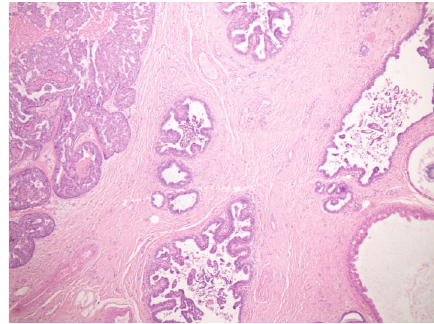
Figure 1: Papillomatosis, × 40.